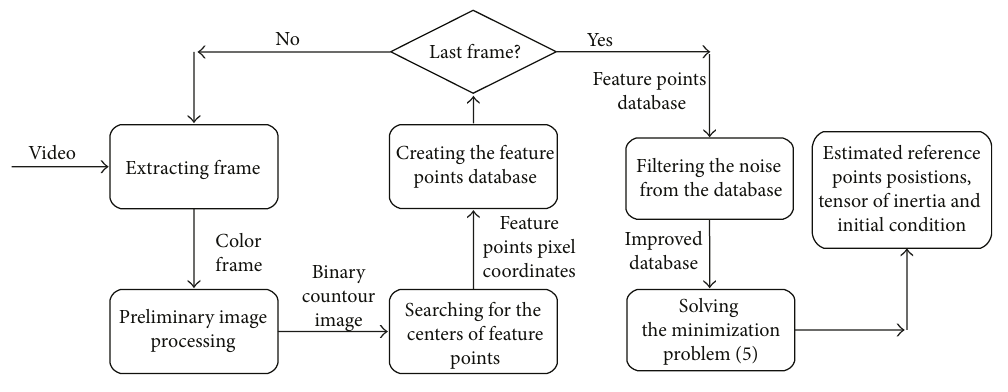
Figure 4: Scheme of an algorithm. Table 1: Database of the measurements of the reference points (in